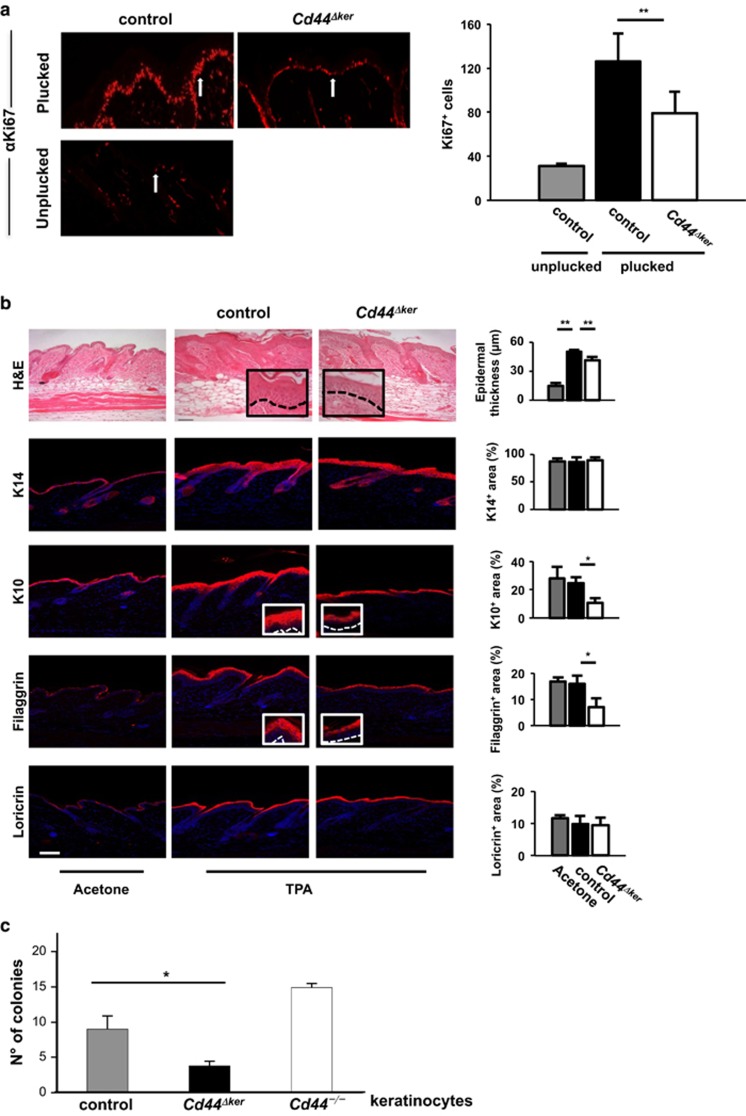
Loss of CD44 leads to impaired keratinocyte proliferation/differentiation. (a) Hair plucking was performed on the dorsal skin of Cd44Δker and control animals. Unplucked skin served as a control. The sections were stained for Ki67 (red) proliferation marker. Quantification is presented on the right side. (b) TPA-treated skin sections of Cd44Δker mice and control animals, and acetone-treated skin sections of control animals were analyzed by H&E (bar=50 μm), K14, K10, filaggrin or loricrin stainings (bar=75 μm). Epidermal/dermal junction is indicated by dashed lines. Quantification of epidermal thickness and of the stained area size, relative to epidermal thickness. (c) Cd44Δker, control and germ-line KO keratinocytes were isolated and subjected to colony formation assay. Bars represent means ±S.E.M., n=5. Student's t test: *P<0.05, **P<0.005. Experiments were performed at least three times and gave similar results